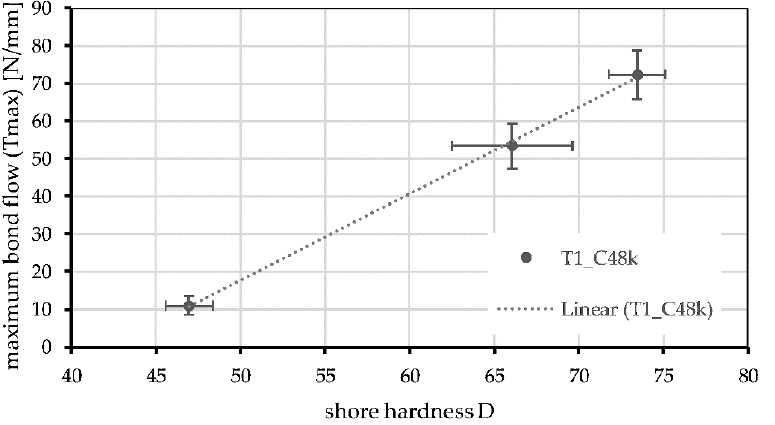
Figure 17. Correlation between maximum bond flow (Tmax) and shore hardness, mean values of 6 (Tmax) and 10 (hardness) single values, standard deviation indicated.